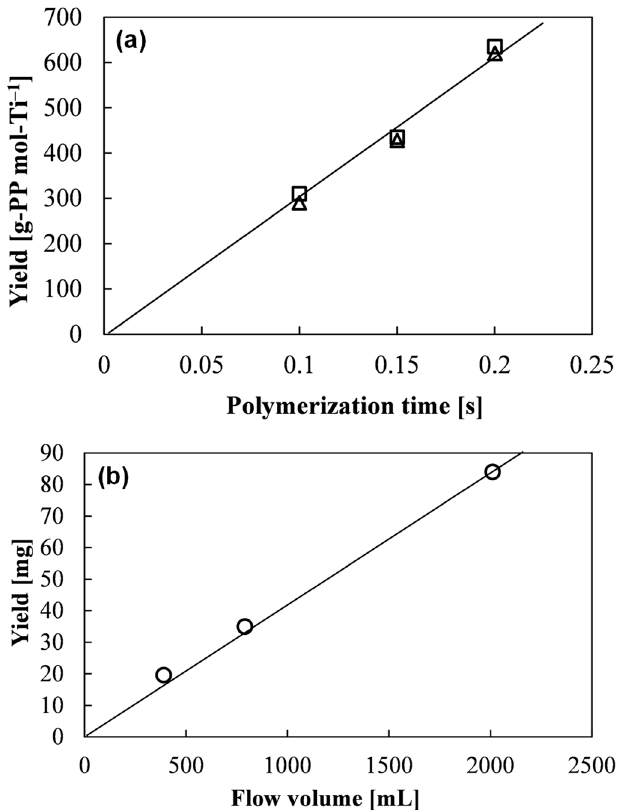
Figure 11. ( a ) Yield development in LSF propylene polymerization using a co-ground catalyst (TiCl 4 /1,3-diether/MgCl 2 ): ( Δ ) New quenching and ( □ ) conventional quenching; ( b ) Scalability test with the new quenching method. The tube length was fixed at 2 s, while the cumulated flow volume was increased [38].